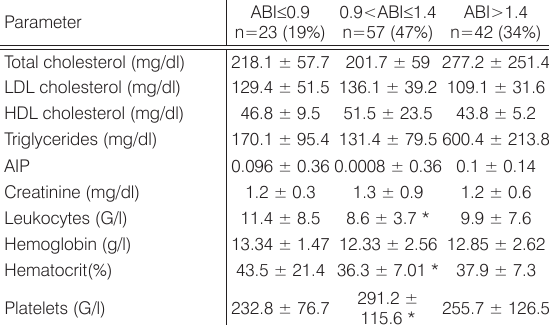
Table 2. The chosen biochemical parameters of subjects.